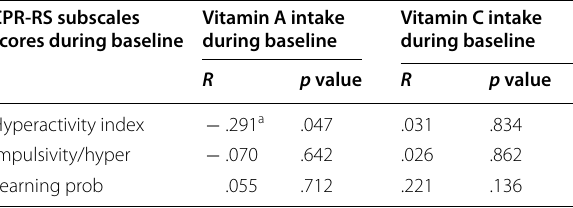
Table 6 Correlation between dietary vitamin A intake and CPR-RS subscales scores during baseline period